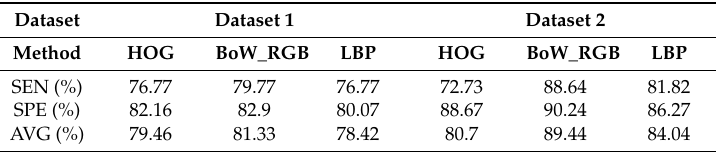
Table 1. Obtained recognition results using single features.